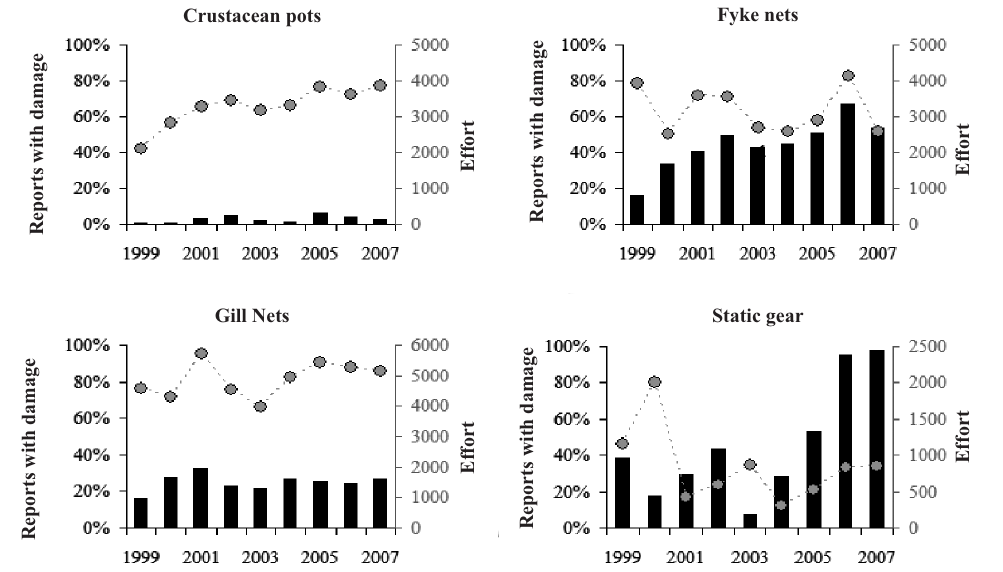
Fig. 1. The amount of fishing effort from the Coastal journal with reported seal damage for fishing boats with lengths under 10 m in the Kattegatt-Skagerrak. Bars indicate the proportion of journals with report- ed seal interactions and circles indicate the yearly effort in 1,000 pot-days for crustacean pots, 1,000 fyke-net-days for eel fyke nets, km net-days for gill nets (different forms of bottom-set nets) and gear-days for static gear (salmon and eel